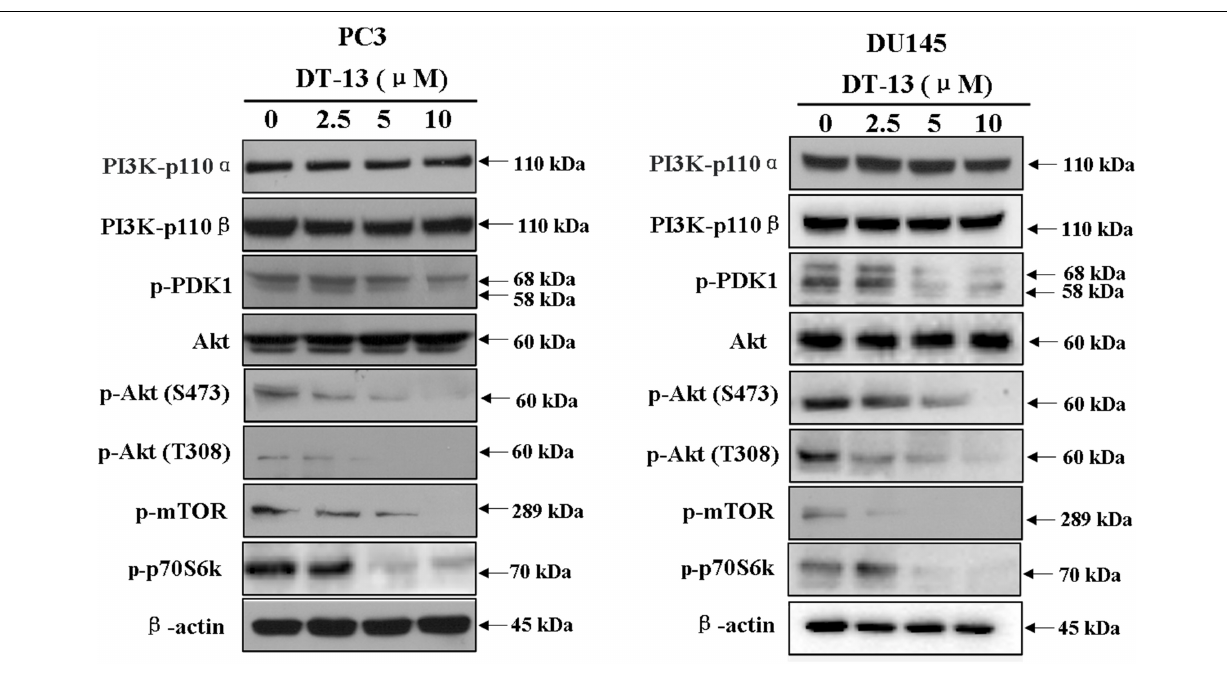
FIGURE 8 | Effect of DT-13 on PI3K/Akt pathway in prostate cancer cells. PC3 and DU145 cells were treated with 0, 2.5, 5, and 10 µ M of DT-13 for 48 h, then the cells were harvested, and the cell lysates were prepared to be available for western blot analysis for PI3K-p110 α , PI3K-p110 β , p-PDK1, p-Akt, Akt, p-mTOR and